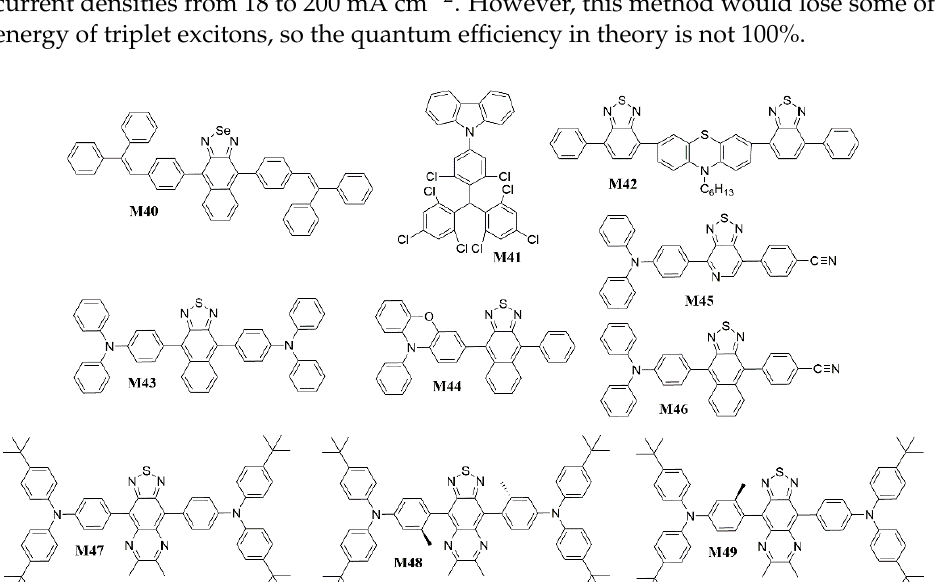
Figure 15. ( a ) The energy levels (left panels) and contour plots (right panels) of the molecular orbitals (LUMO, SUMO, SOMO, and HOMO) of M41 . ( b ) The EL spectrum (7 V) of the OLEDs accompanied by the PL spectra of the doped thin film. The inset shows a photograph of the M41 -based OLEDs operating at 7 V (adapted from ref. [49]).